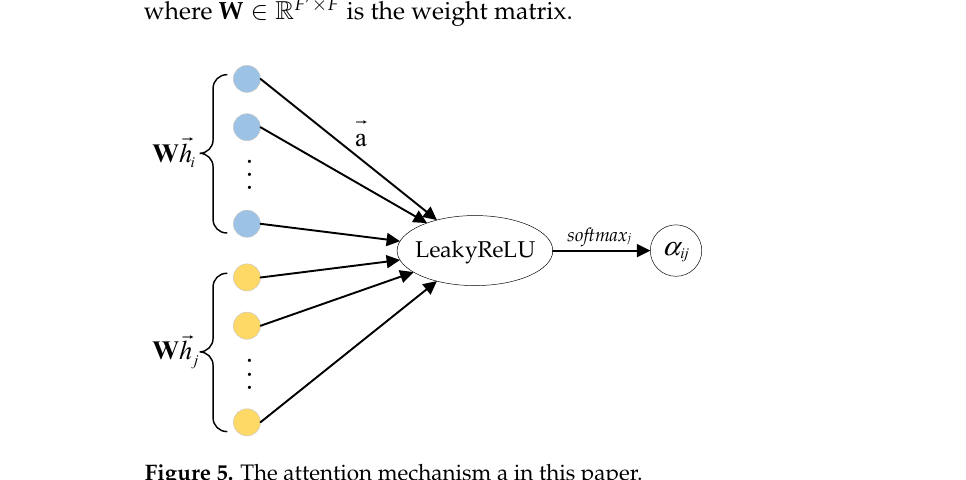
Figure 5. The attention mechanism a in this paper.